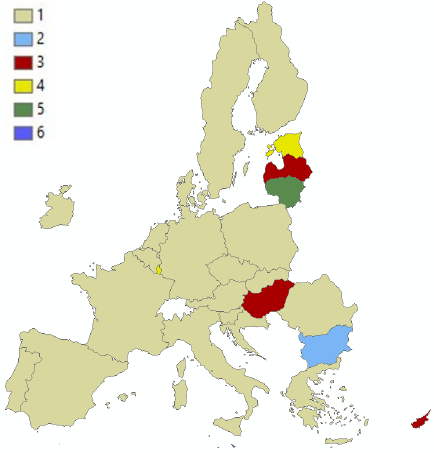
Figure A1. Geographic representation of the countries by category.